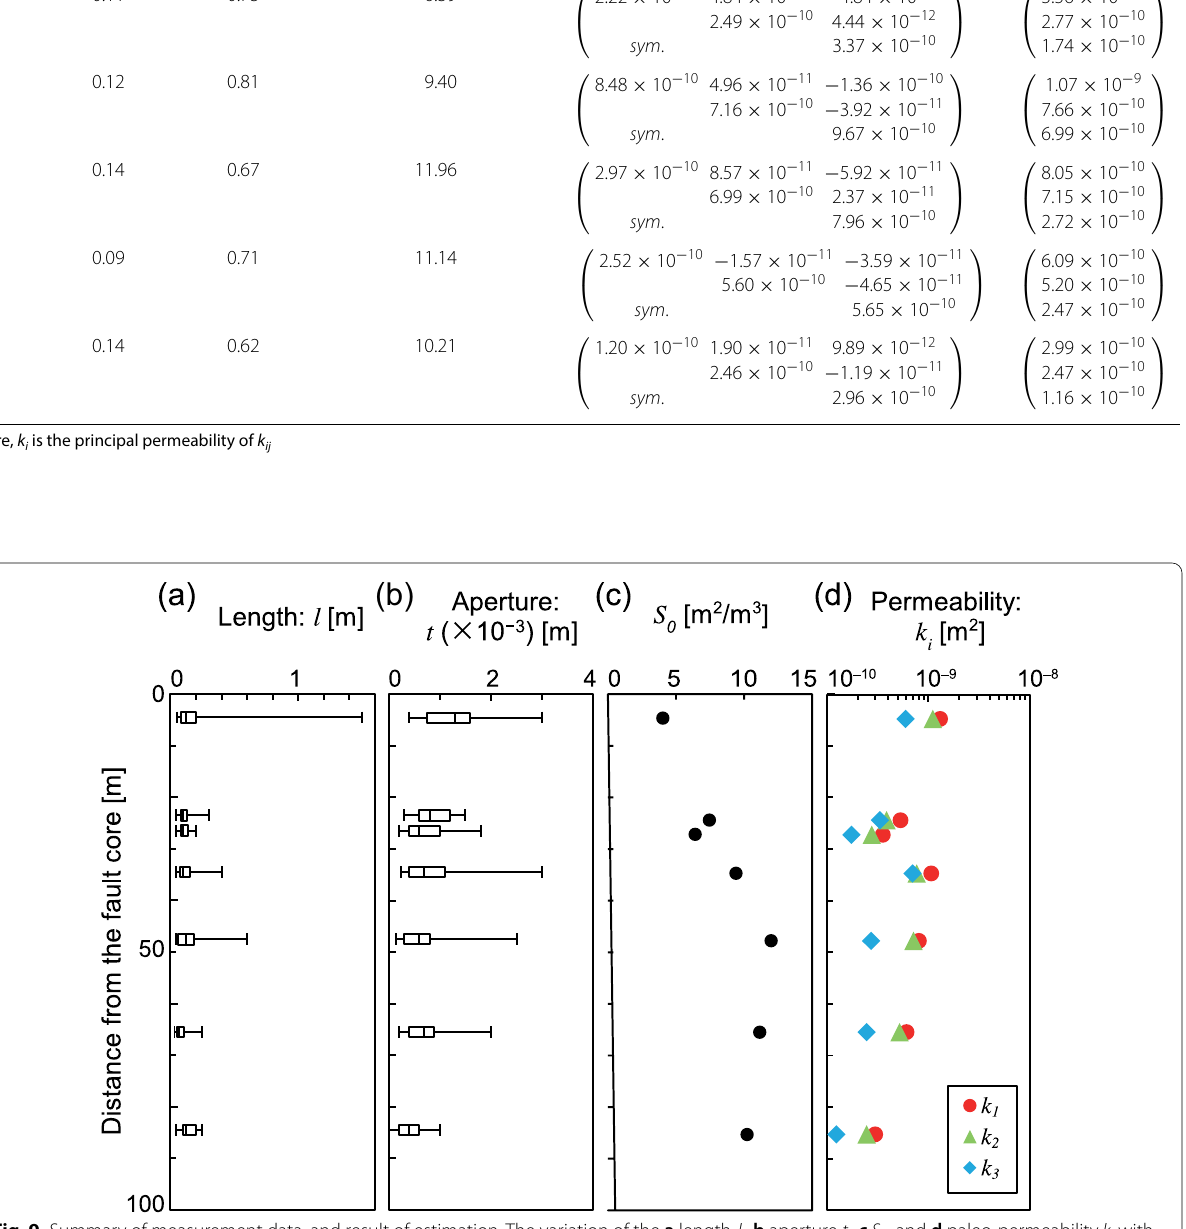
Fig. 9 Summary of measurement data, and result of estimation. The variation of the a length l , b aperture t , c S 0 , and d paleo-permeability k i with the distance from the fault